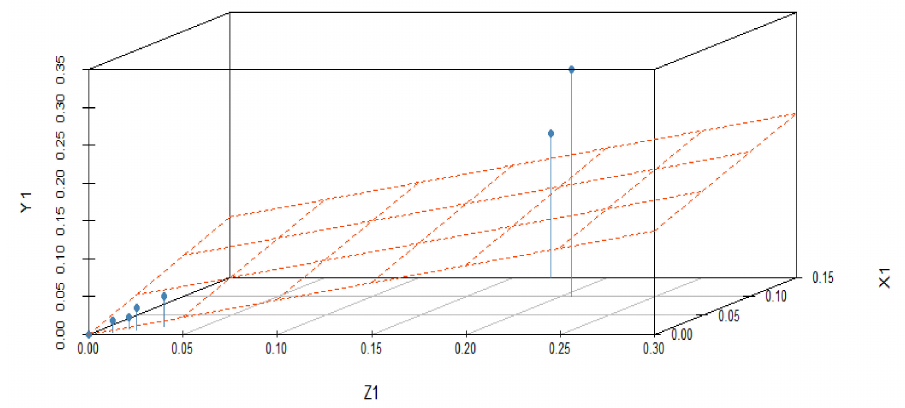
Figure 3. Representation of correlation among the dependent and predictor variables for a difference of 0.02 in experimentally fixed value at 420 ◦ C.